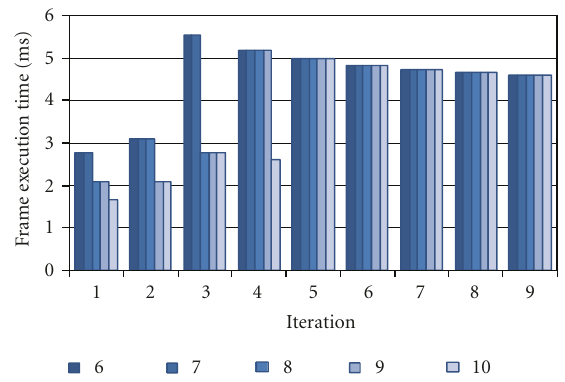
Figure 6: Frame execution time for ILVA with di ff erent CNN sizes, when slicing is required. The legends, 6 to 10, represent the number of pipelines, that is, the number of columns in the design.